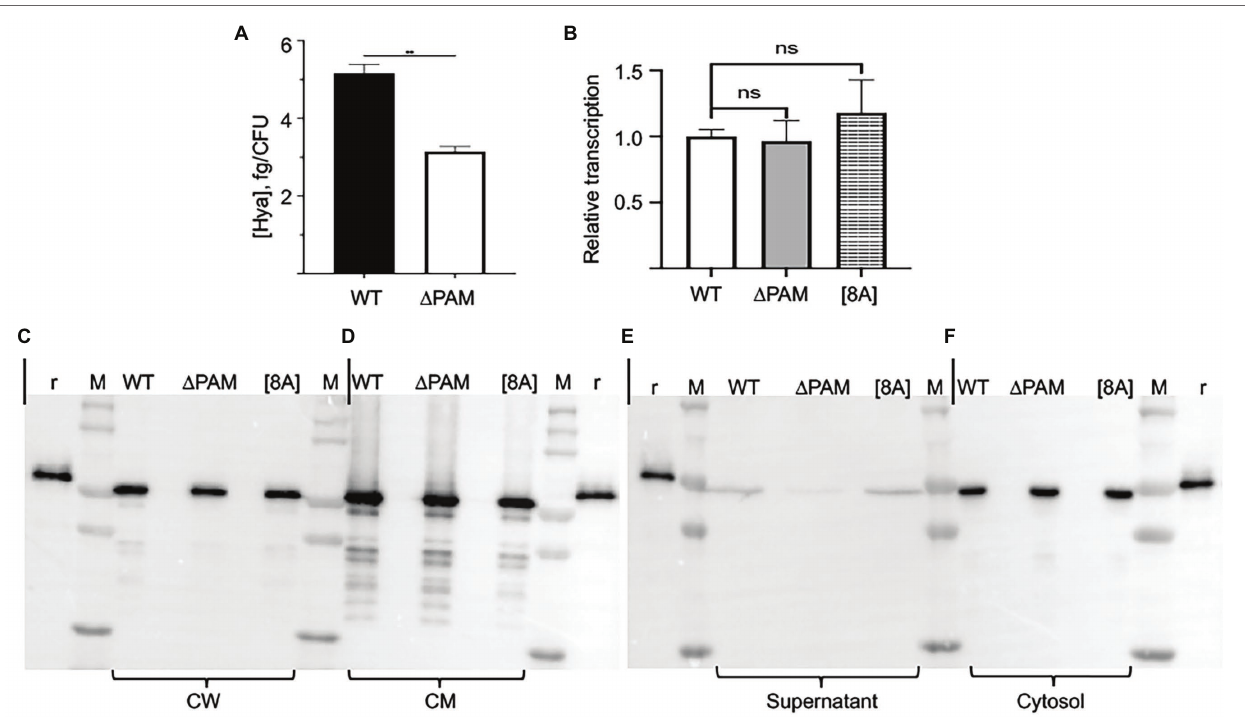
FIGURE 7 | Expression of Sen in subcellular compartments of AP53, AP53/ Δ PAM, and AP53/ pam[8A] cells. (A) Quantitation of the capsule in WT-AP53 and AP53/ Δ pam isogenic cells. Mid-log cells were separated in two fractions, one for determination of the CFU and the other for determination of hyaluronic acid (Hya). Hya standards were also employed. The results are expressed as fg Hya/CFU. (B) Transcription of Sen in isogenic AP53 cell lines. Total RNA from mid-log phase AP53, AP53/ Δ pam , and AP53/ pam[8A] isogenic strains were used to quantitate sen gene transcription using the same primers as for RT-PCR. The relative gene expression levels were analyzed by the 2 −ΔΔ Ct method. The statistical means of triplicate Ct values were calculated. GAPDH was used as the reference gene for both WT and mutant strains. Expression of Sen in mid-log phase cells of various genotypes: (C) cell supernatants (15x concentrated); (D) cell walls (CW); (E) cell membranes (CM); (F) , cell cytosols. In all cases: r, recombinant Sen; M, molecular weight marker; WT-AP53 cells (WT); AP53/ ∆pam cells ( ∆ PAM); AP53/ pam[8A]